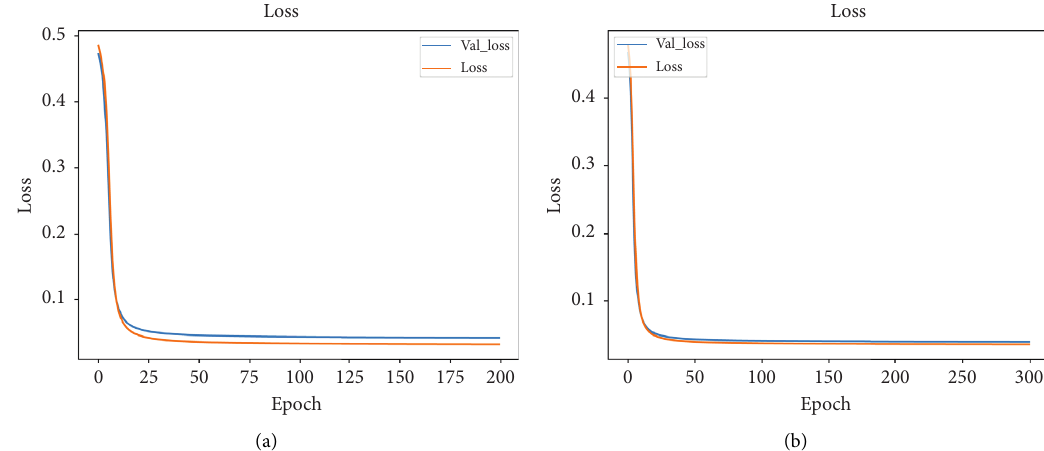
Figure 6: Training loss for data without and within restriction periods. (a) The loss for training workday morning data without restriction. (b) The loss for training workday morning data with restriction.